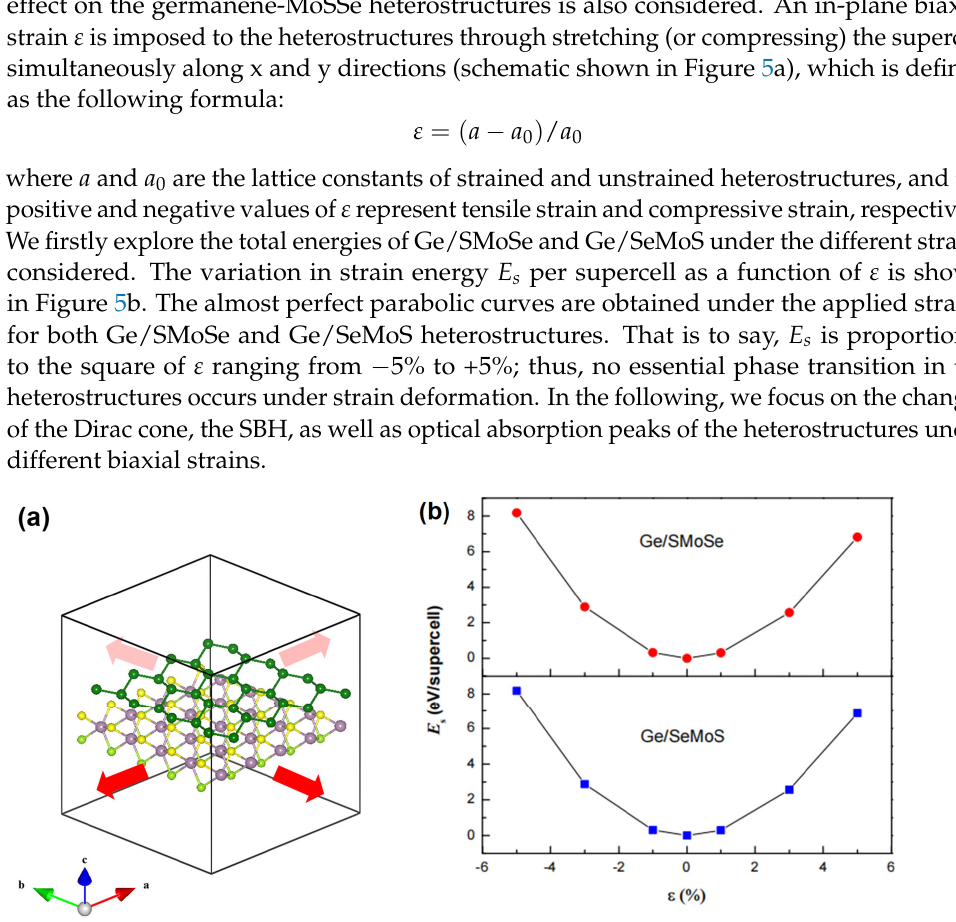
Figure 5. ( a ) The schematic map of Ge/SMoSe heterostructure under in ‐ plane tensile biaxial strain ( b ) The variation of strain energy E s as a function of applied biaxial strain ranging from − 5% to 5%.